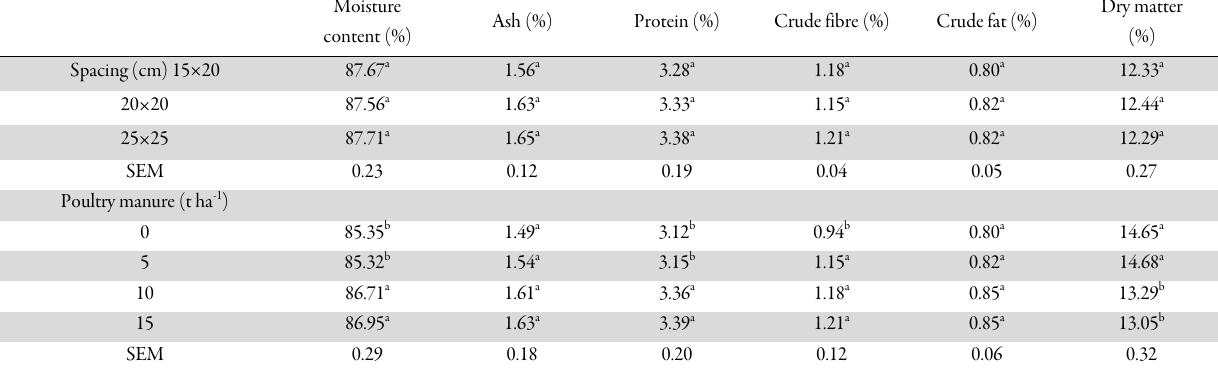
Table 9. Effect of poultry manure rates and spacing on the proximate composition of onion